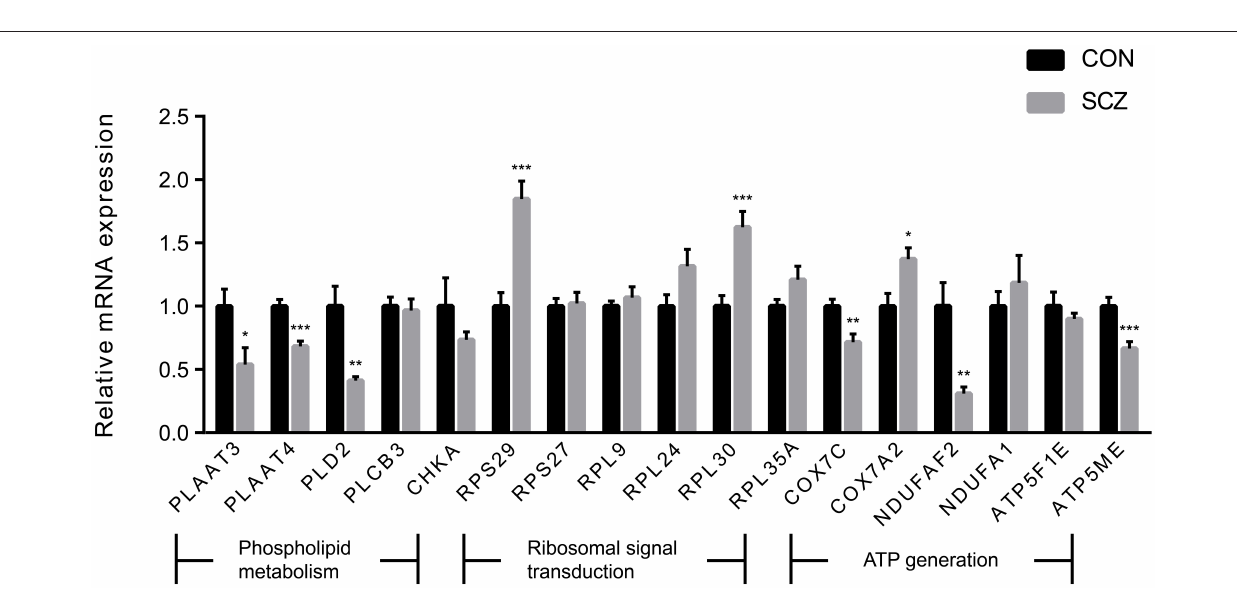
FIGURE 5 | The expression levels of genes of interest. Values are exhibited as mean ± standard error of mean (n = 12 per group). Significant differences are denoted as follows: * p -value < 0.05, ** p -value < 0.01, *** p -value <